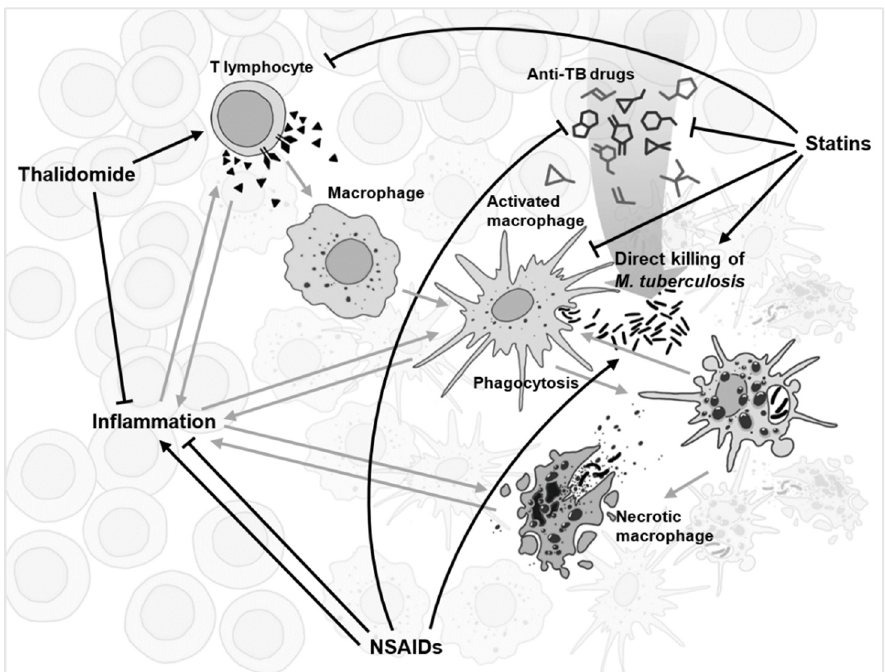
Figure 1. A simplified schematic of the complex network of interactions (grey) during tuberculosis infection within a granuloma. Several drugs with the most conflicting experimental evidence, and yet with repurposing potential for anti-TB adjunct therapy, are displayed with their suggested network of interactions shown (black).